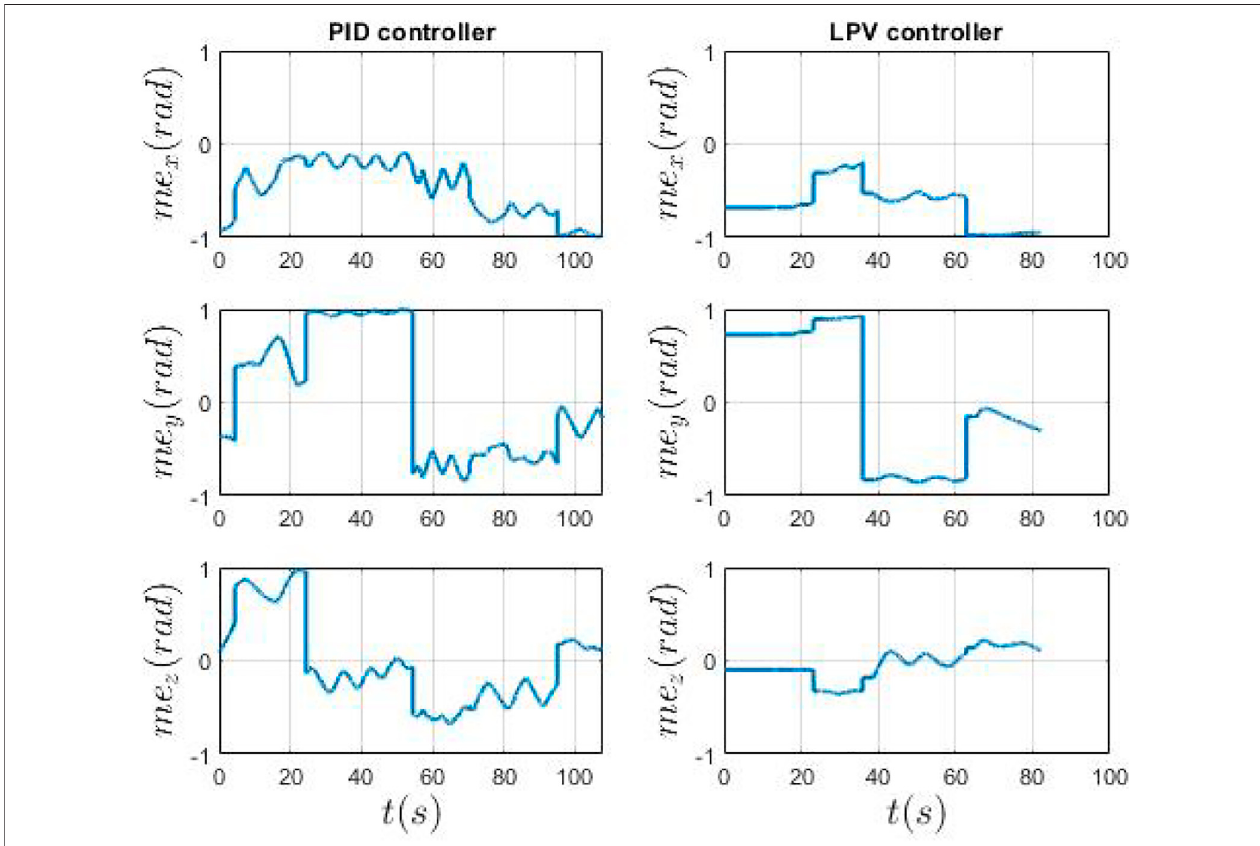
FIGURE11| RealEPMmagneticmomentinworldframe.OntheleftthePIDcontrolandontherighttheLPVcontroller.TheEPMmagneticmomentiscomputedby the controller, at each cycle, given the IPM magnetic moment error.